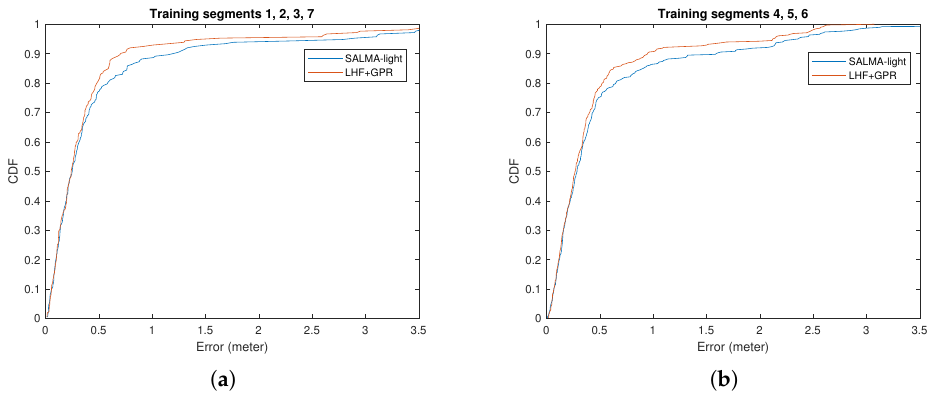
Figure 10. CDF of the localization error using ( a ) training segments 1, 2, 3, 7, ( b ) training segments 4, 5, 6. The blue solid line plots the error CDF obtained when SALMA-light is used. The orange solid line plots the error CDF obtained when optimizing the LLHF with prior knowledge from GPR. The phase ζ k is approximated by using the phase from CIR. Overlap checking is performed first before implementing the